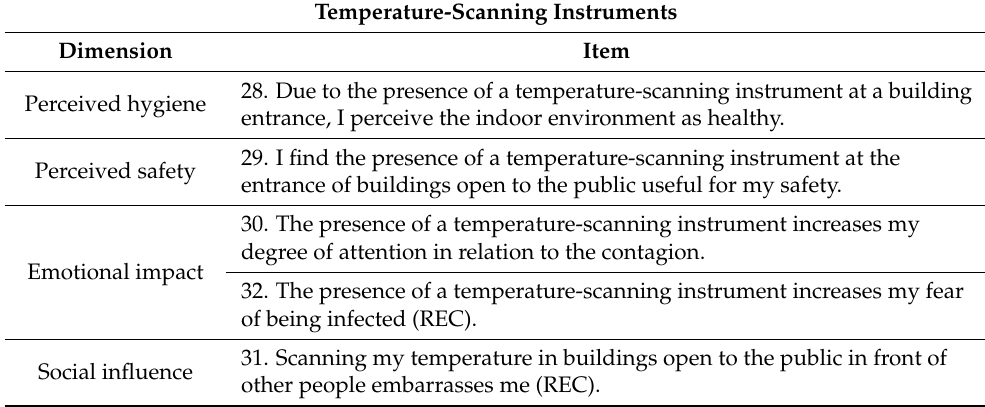
Table 3. Items examined for the temperature-scanning instruments in the online survey and related dimensions. Own